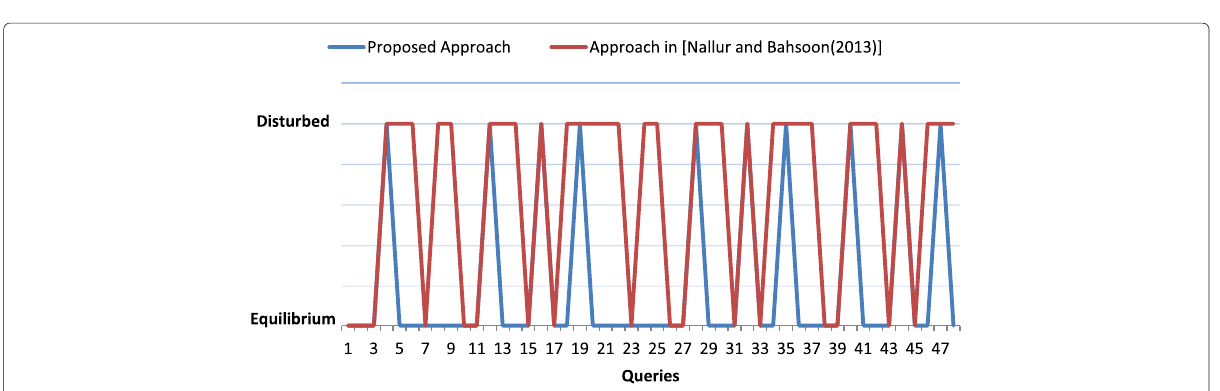
Fig. 11 State of equilibrium in case of [17] and proposed approach